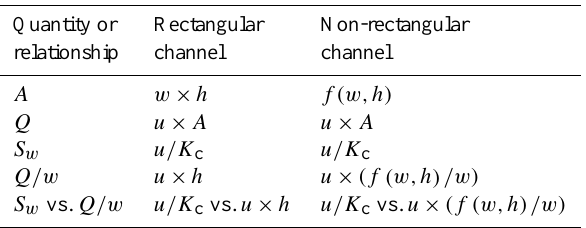
Table 1. The relationship S w vs. Q/w for natural-channel geome- tries. Quantity or Rectangular Non-rectangular relationship channel channel A w × h f (w,h) Q u × A u × A S w u/K c u/K c Q/w u × h u × (f (w,h)/w) S w vs. Q/w u/K c vs. u × h u/K c vs. u × (f